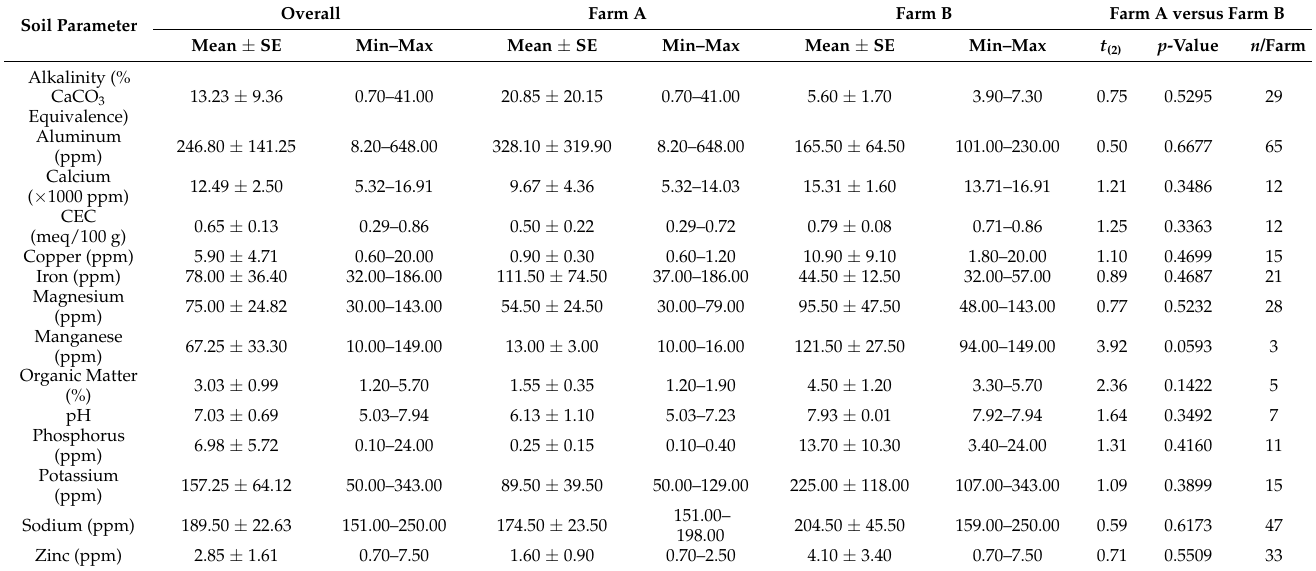
Table 3. Sediment chemistry parameters (mean, standard error ( SE ), minimum measurement (min), and maximum measurement (max)) measured in soil samples collected from 2 farms (2 ponds per farm), test statistics ( t ) and p -values of statistical comparison between farms, and the sample size ( n ) required to reveal statistically significant differences between farms.